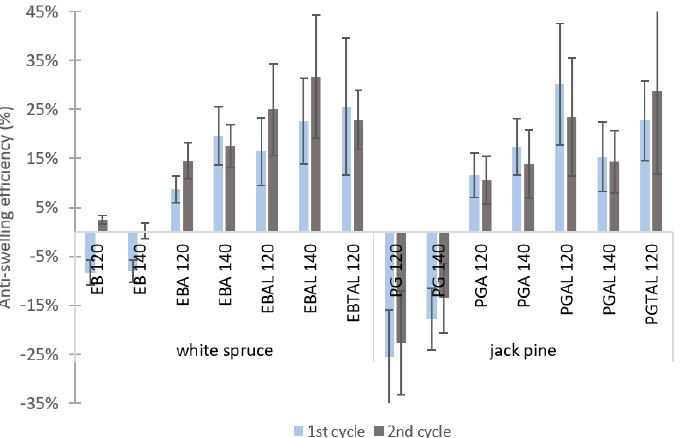
Figure 3. ASE v to immersion for the different treatments on white spruce and jack pine after two cycles.